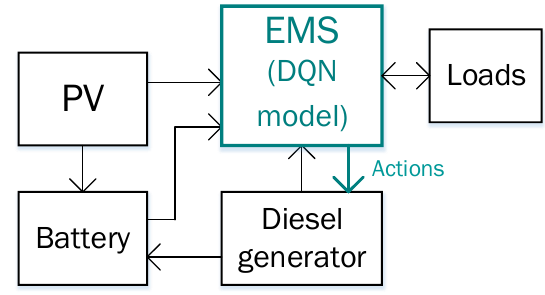
Fig. 13. Schema of the MG featuring PV panels associated with a battery, a hydrogen storage and diesel unit